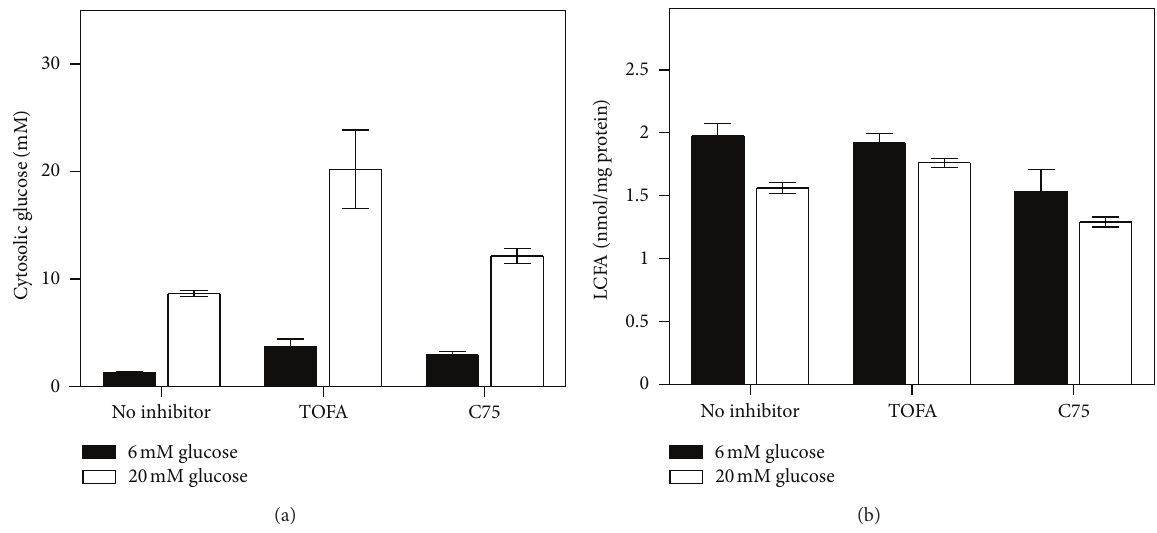
Figure 13: Cytosolic glucose (panel a) and free fatty acid (LCFA, panel b) levels in mouse primary hepatocytes cultured with and without TOFA or C75. Hepatocytes were incubated with TOFA or C75 (10 𝜇 g/mL) with 6 or 20mM glucose (Section 2). Cytosolic glucose level was then determined as in Methods. Briefly, hepatocytes were washed quickly with ice old solution of MgCl 2 (100mM) with 0.1mM phloretin. Cells were then homogenized with a probe sonicator and, after centrifugation, the supernatant was used for glucose analysis with the Amplite Glucose Quantitation Kit as instructed by the manufacturer. For LCFA determination, hepatocyte homogenate was extracted twice with 1% Triton X-100 in pure chloroform. The organic phase was collected, and the FFA content of each sample was measured with the Free Fatty Acid Quantification Kit from BioVision, Inc. according to manufacturer’s instructions using enclosed palmitic acid as standard. Mean ± SEM, 𝑛 = 3